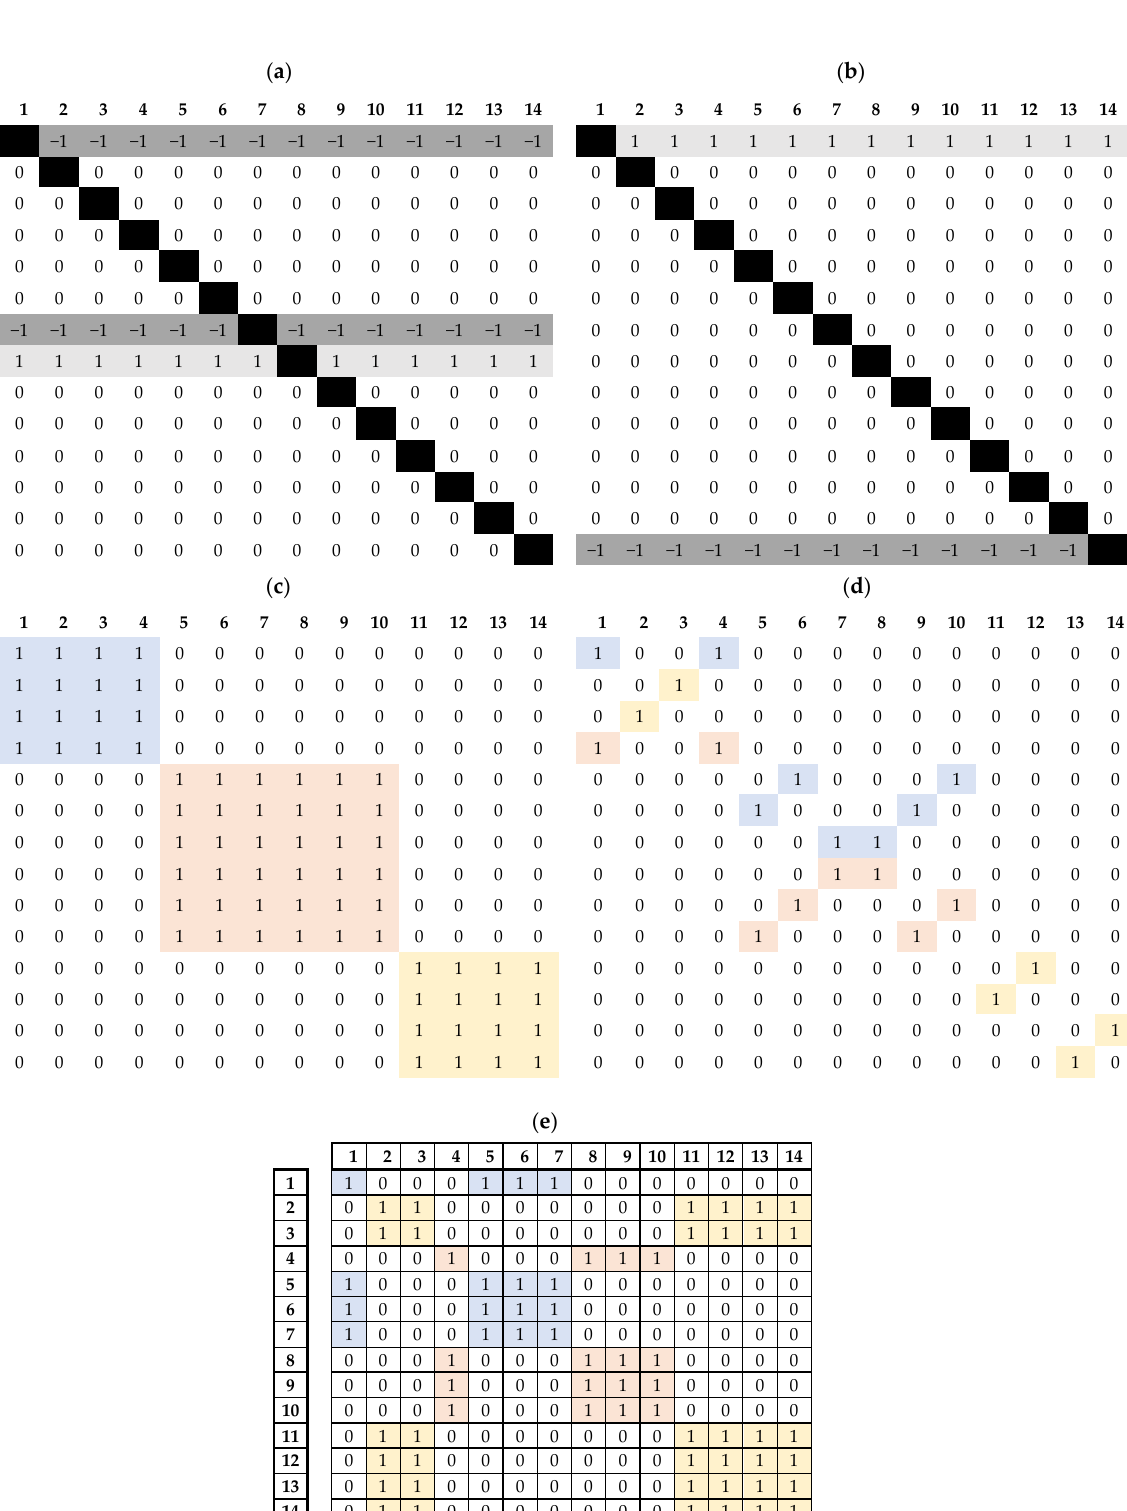
Figure 3. One-hot encoded matrices used to provide: ( a ) boundary constraints in the x axis (Figure 2b); ( b ) boundary constraints in the y axis (Figure 2b); ( c ) row regularity constraints (Figure 2b); ( d ) symmetry relations (Figure 2c); and ( e ) symmetry island grouping (Figure 2c) to the deep